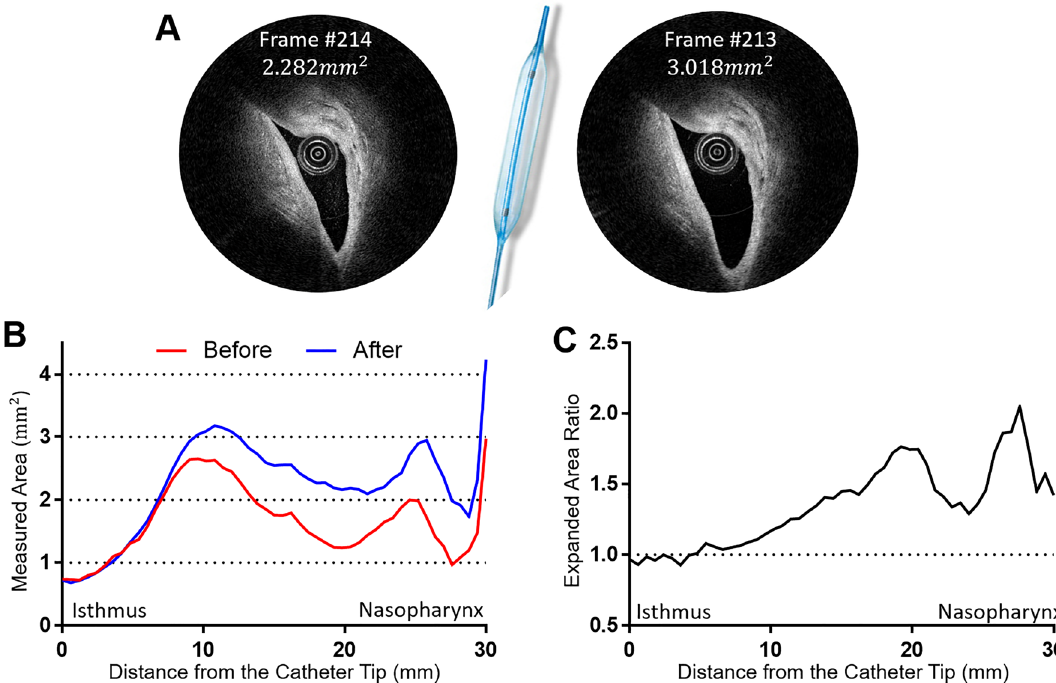
Figure 6. Changes in the luminal area before and after balloon dilatation of the Eustachian tube. The cross- sectional area was calculated by converting the pixels (per inch) into areas (mm 2 ). The areas of the same location were compared before and after balloon dilatation. In the mid-portion of the Eustachian tube ( B ), the luminal area increased from 2.282 to 3.018 mm 2 ( A ). The widest luminal area was measured at around 10 mm inferior from the isthmus ( B ). The luminal area ratio before and after balloon dilatation tended to increase as it moved toward the nasopharyngeal opening of the Eustachian tube ( C ). The a, b, c, and d in ( B ) indicate corresponding locations presented in Fig.